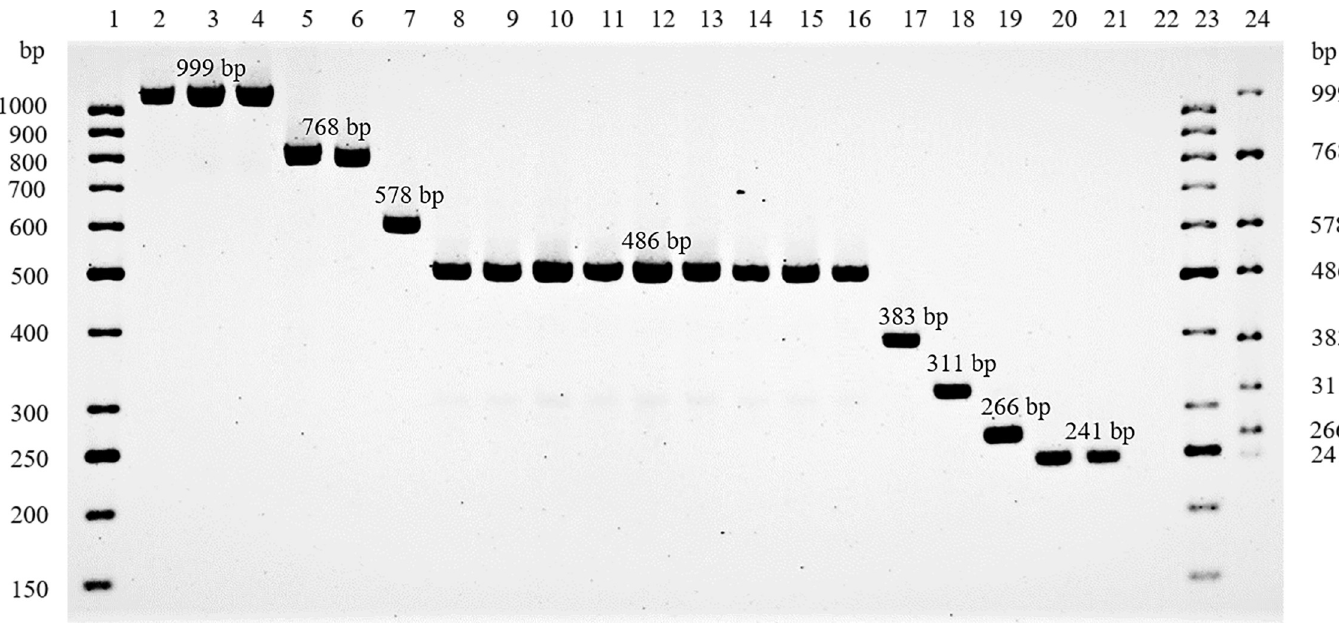
Fig 3. A multiplex PCR assay for 20 untypeable C . jejuni , CJ001 to CJ020. Lanes 1 and 23 are 50 bp DNA Ladder (GeneRuler, Thermo Scientific). Lanes 2 to 21 represent PCR products of CJ001-CJ020 using the 8 newly designed primer pairs based on 8 different unique sequences from each group. Lane 22 is a negative control. Lane 24 represents a mixed PCR products, a multiplex PCR assay using representative DNA template from each group.